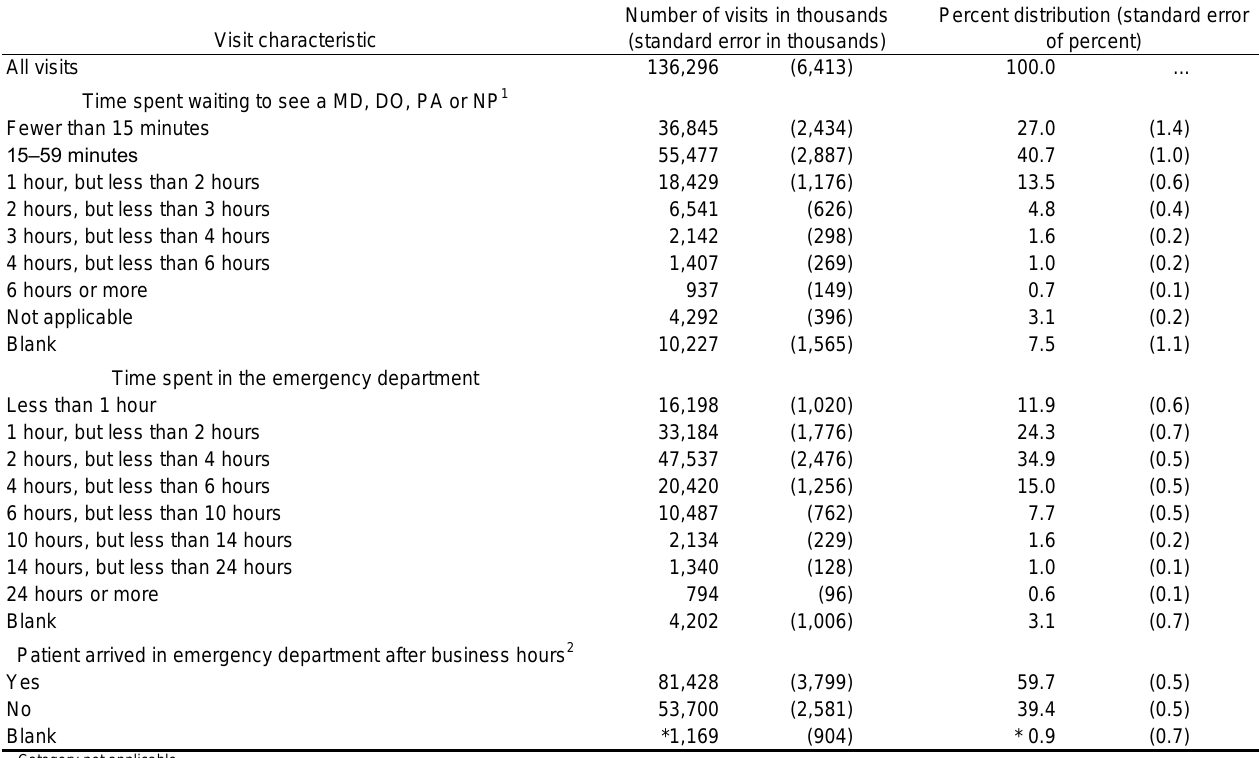
Table 4. Wait time at emergency department visits: United States, 2011